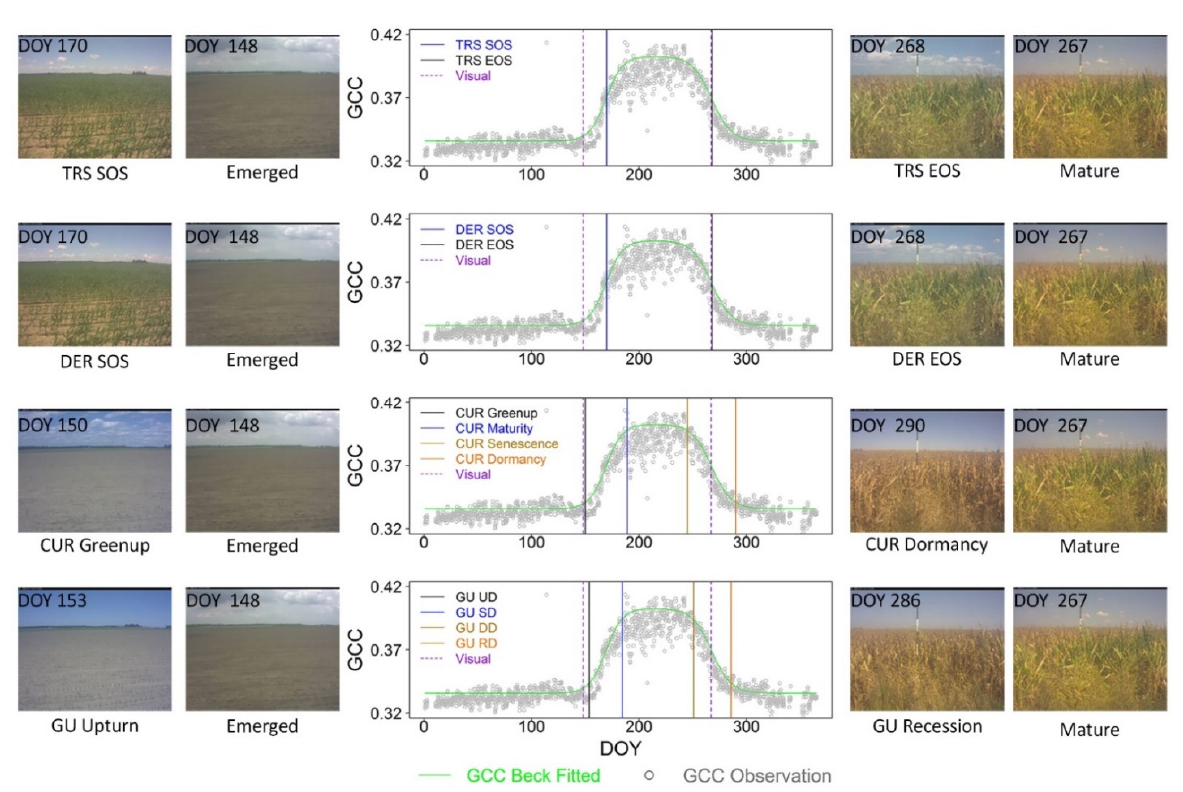
Figure 4. The PhenoCam GCC observations fitted by the Beck double logistic model for the corn site of the University of Illinois Energy Farm in 2017. With the Beck fitted curve, four phenophase analysis methods (i.e., TRS-based, DER-based, CUR-based, and Gu-based methods) were employed to extract phenological metrics to be compared with corresponding visual observations. For this site-year, the visually observed crop emergence date was DOY 148, and the observed crop maturity date was DOY 267. The PhenoCam photos of the extracted metric and visual observation dates were also shown in this figure.